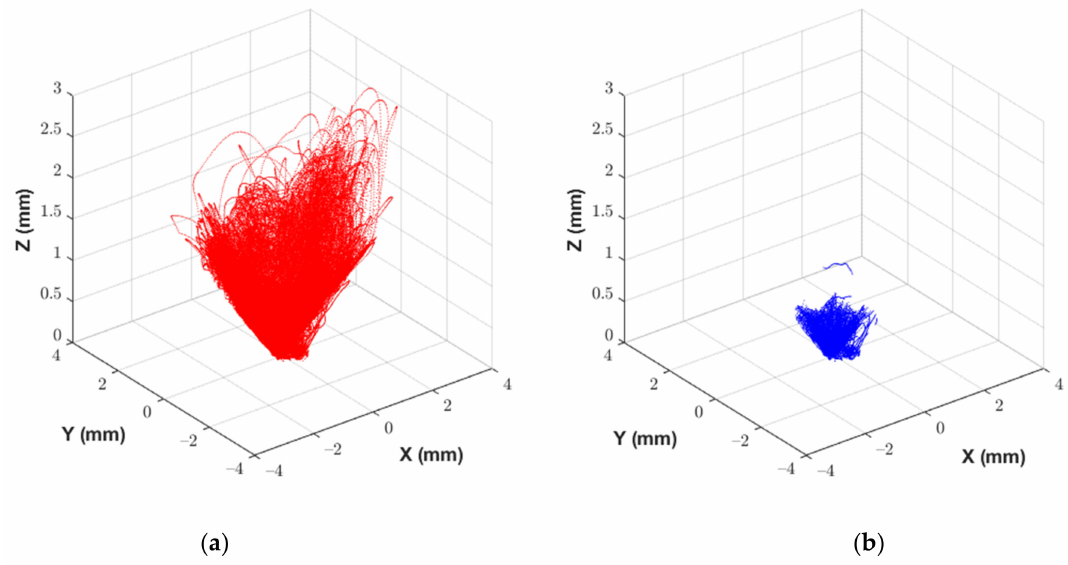
Figure 4. Reference displacement data measured by the FARO arm. ( a ) Full reference dataset for measured displacements at the interface. ( b ) Reduced reference dataset for use during